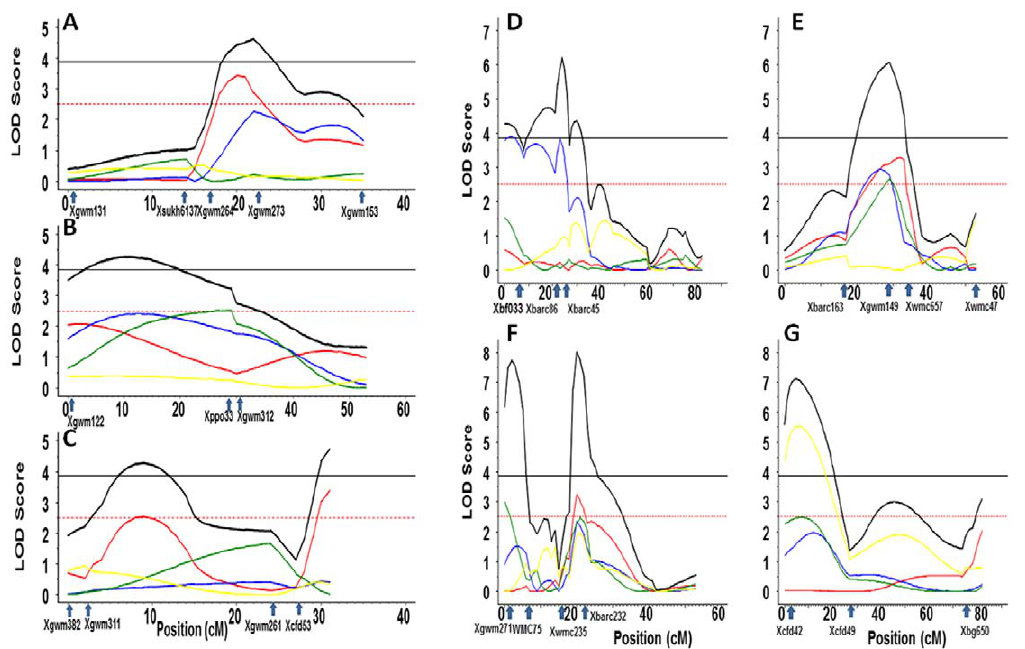
Figure 2. Multi-trait analysis and locations of QTL for resistance to KB, TS, Yr and Lr. ( A ) chromosome 1BS with marker Xsukh6137 (at 14 cM), marker Xgwm264 (at 17 cM) and marker Xgwm273 (at 22 cM) where the QTL are located; ( B ) chromosome 2A with marker Xgwm122 (at 0 cM), marker Xppo33 (at 29 cM where the QTL is located), and marker Xgwm312 (at 30 cM); ( C ) chromosome 2DS with marker Xgwm311 (at 2 cM) and marker Xgwm261 (at 24 cM); ( D ) chromosome 3AS with marker Xbarc86 (at 21 cM), marker Xbarc45 (at 24 cM where the QTL is located), Xbem29 (at 27 cM), and Xbem7 (at 35 cM); ( E ) chromosome 4BL with marker Xbarc163 (at 18 cM), marker Xgwm149 (at 28 cM where the QTL is located), marker Xwmc657 at 34 cM; ( F ) chromosome 5BL with marker Xgwm271 (at 2 cM where the QTL is located), marker Xwmc75 (at 6 cM), marker Xwmc235 (at 20 cM) and marker Xbarc232 (at 22 cM) and ( G ) chromosome 6DS with marker Xcfd42 (at 0 cM where the QTL is located), and marker Xcfd49 (at 27 cM). LOD scores are plotted against marker location. QTLs profiles legend with color red, blue, green, yellow, and black indicate KB, TS, Yr, Lr, and joint effect respectively. Horizontal lines with black solid color mean threshold for Joint profile, and red dashed is threshold for marginal profiles.